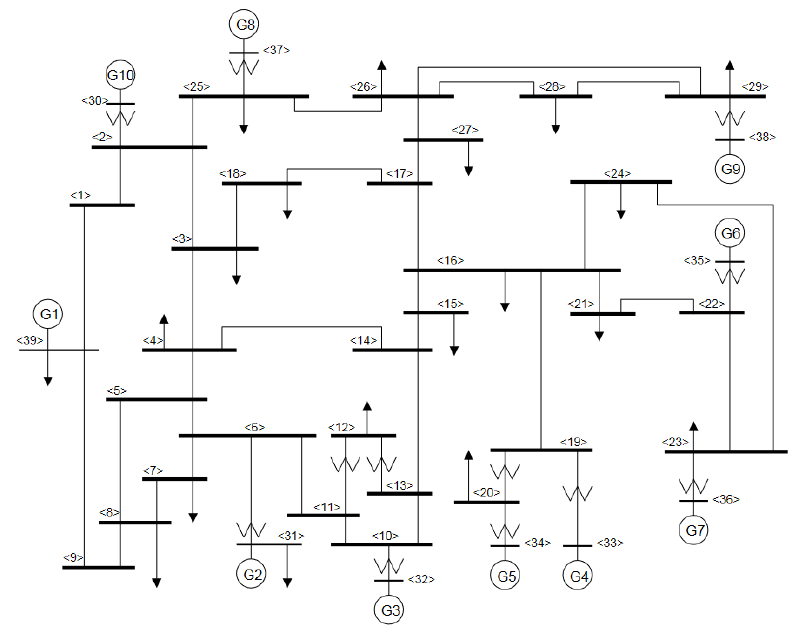
Figure 11. New England 10-machine, 39 bus system, Adapted from [28].